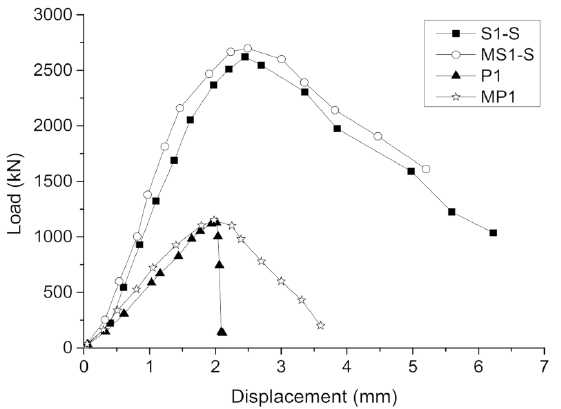
Figure 12. Finite element model. ( a ) Model of specimen P1; ( b ) Model of specimen S1-S.